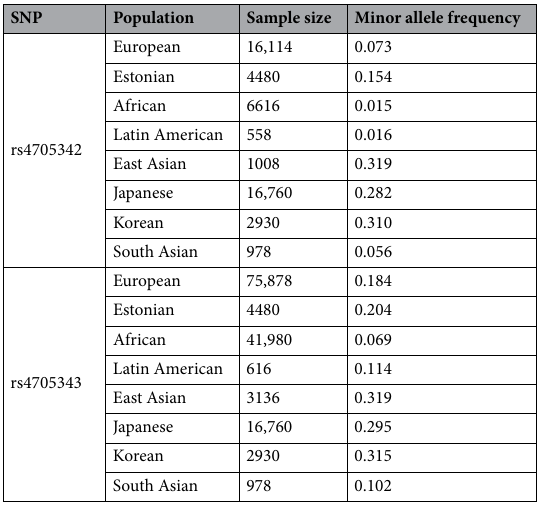
Table 6. Minor allele (C allele) frequencies of rs4705342 and rs4705343 in different ethnic groups. Data were extracted from https:// www. ncbi. nlm. nih. gov/ snp/ rs470 5342 and https:// www. ncbi. nlm. nih. gov/ snp/ rs470